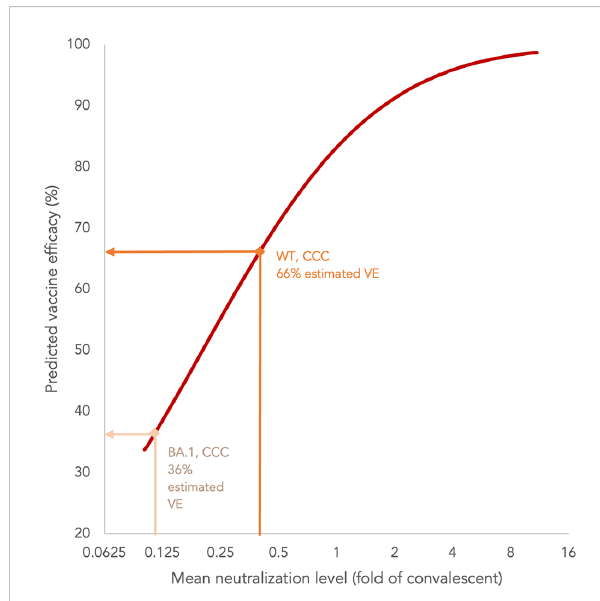
FIGURE 5 Estimation of vaccine ef fi cacy (VE) of three doses of CoronaVac (CCC) based on neutralization titres against wild-type (WT) and BA.1 SARS-CoV-2 in